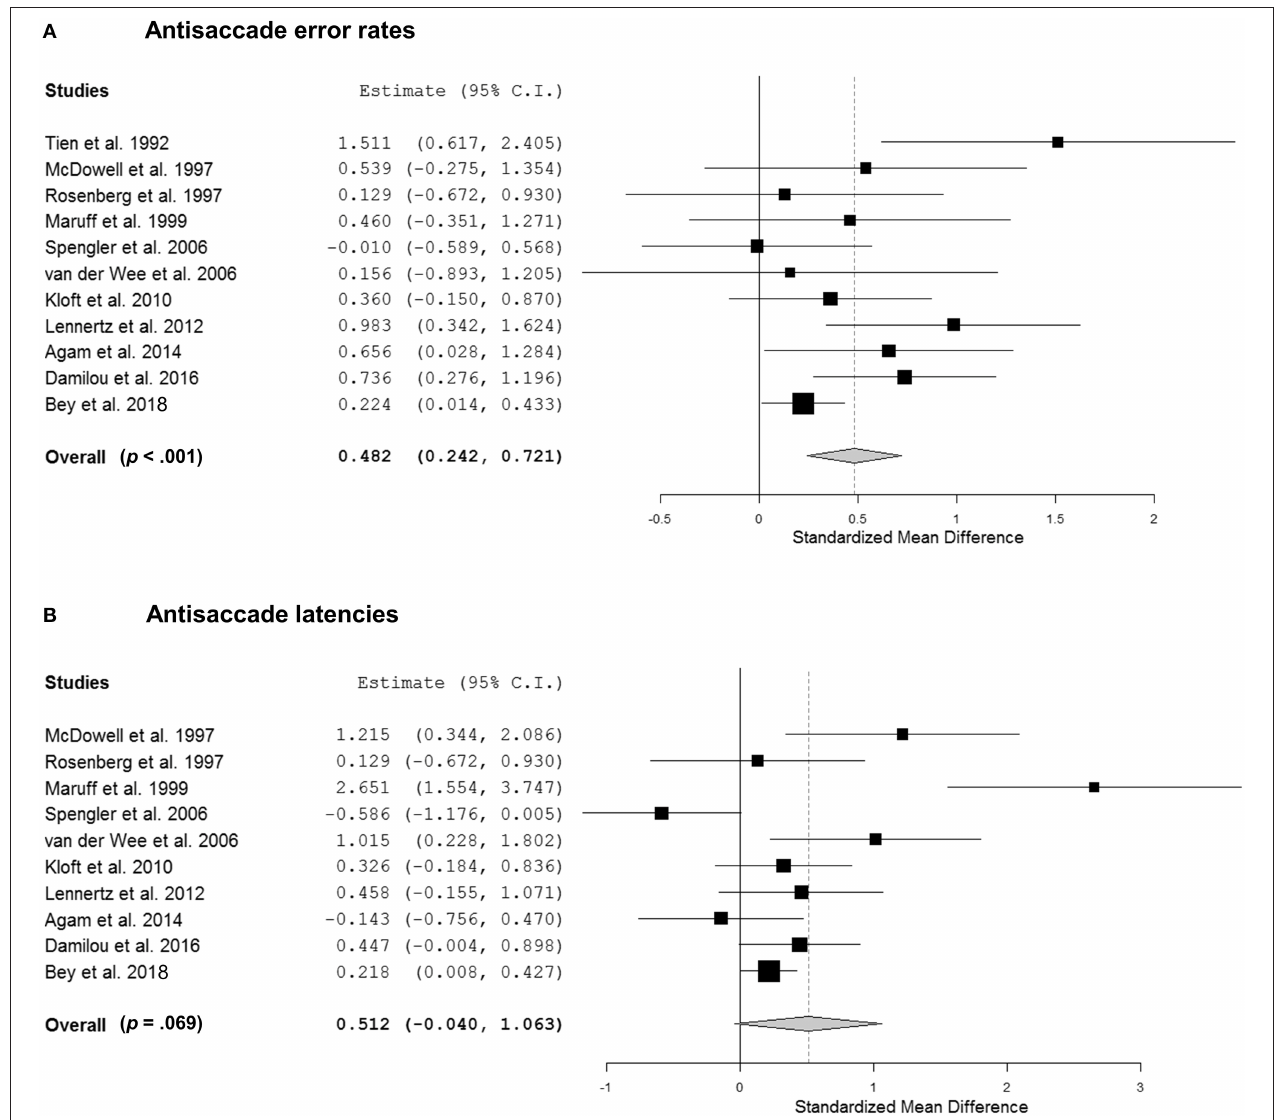
FIGURE 4 | (A) Forest plot showing effect sizes for antisaccade error rates in patients with obsessive-compulsive disorder (OCD) as compared to healthy control subjects. Higher values indicate higher error rates in patients. (B) Forest plot portraying the effect sizes for antisaccade latencies in patients with OCD as compared to healthy control subjects. Higher values indicate longer latencies in